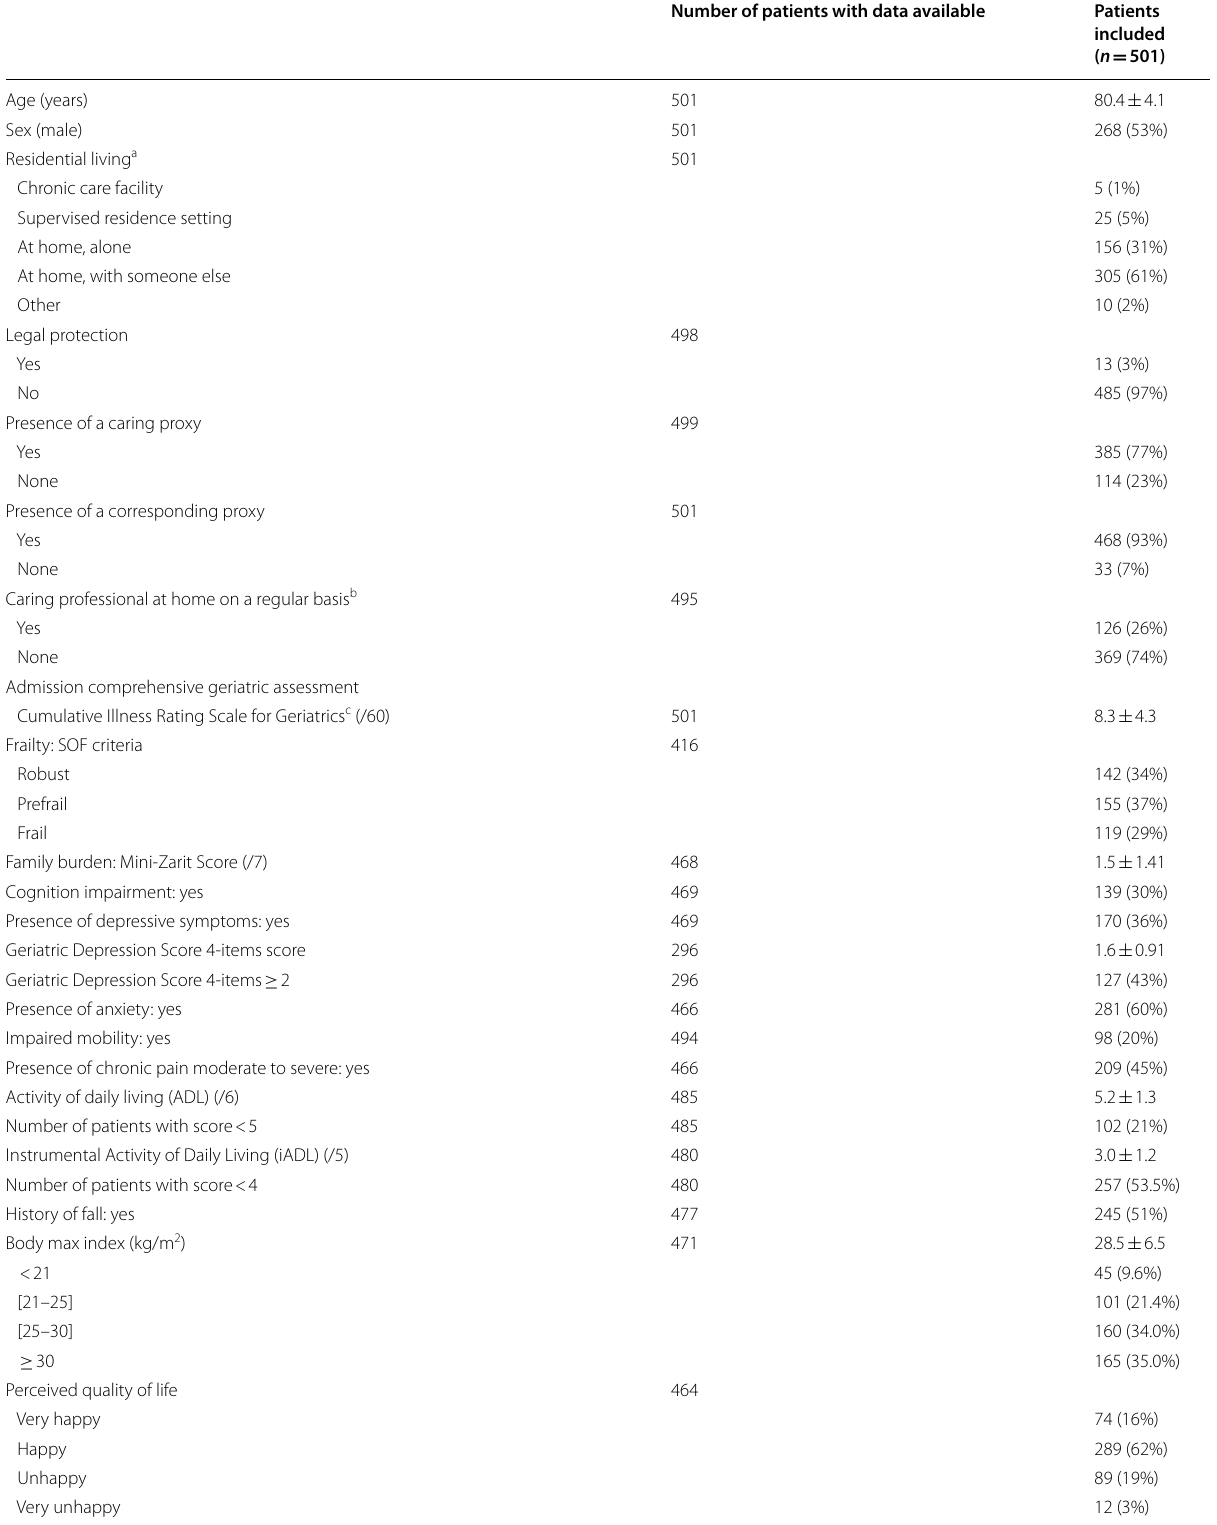
Table 1 Baseline characteristics and admission comprehensive geriatric assessment of the 501 included patients Number of patients with data available Patients